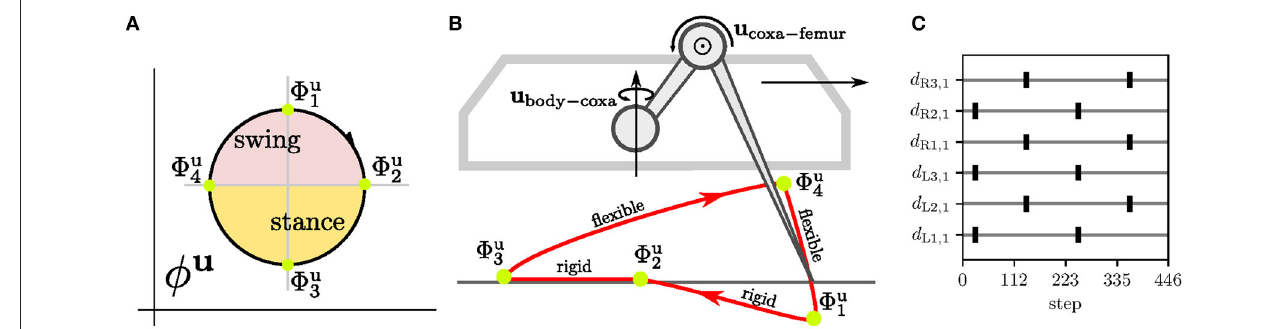
FIGURE 5 | The leg motion control and the inter-limb synchronization for the tripod gait. (A) For each j -th joint, the motion is divided into four phases 8 u j ,1 , 8 u j ,2 , 8 u j ,3 , 8 u j ,4 . (B) At the k -th phase, the j -th joint is controlled by the set control command u j , k that sets the joint angle u leg performs the motion with the foot-tip trajectory. The leg is rigid (high maximum torque set on joints) during stance so it can propel the body forward, while during the swing, the leg is flexible (low maximum torque) and stops on the obstacle contact. The contact is detected as the difference between the expected and measured positions. The ground contact is measured by poking the end of the swing at 8 u j ,1 when the flexible leg tries to lower the foot tip below the expected ground. (C) The relation between motion phases of each leg depends on the gait. During the tripod gait, two groups of legs move together, where the first group is composed of the left front/hind (L1, L3) and right middle leg (R2), and similarly the second with legs R1, R3, and L2. The phase relations for the tripod gait is trained by the target signal d . Targets for the l -th leg’s coxas d l ,1 representing motor phase 8 u l ,1 are shown in the plot. A single gait cycle is 223 steps